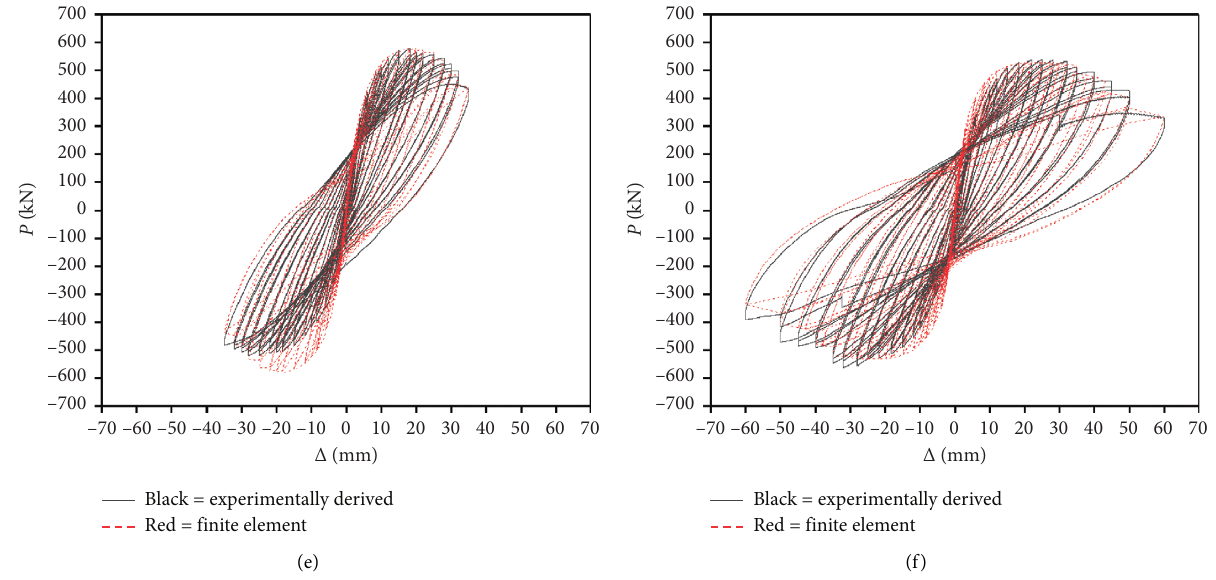
Figure 13: OpenSees finite element simulations compared with the experimentally derived hysteresis curve for each specimen. Results comparison of (a) SC-1, (b) SC-2, (c) SC-3, (d) SC-4, (e) SC-5, and (f)